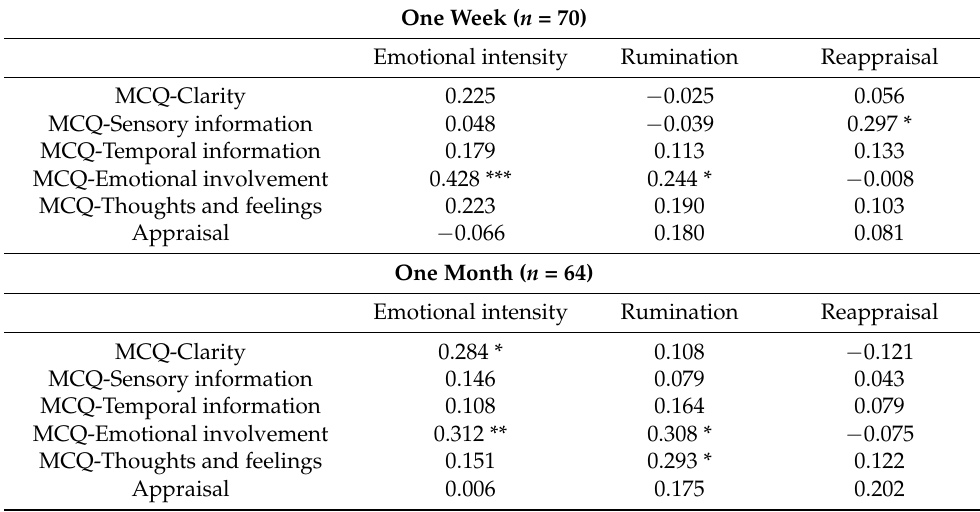
Table 1. Correlations of emotional intensity and emotion regulation with autobiographical memory characteristics were assessed through the Memory Characteristics Questionnaire (MCQ). Change in appraisal scores were obtained by calculating the absolute delta scores between the momentary ratings and the one-week/one-month follow-up